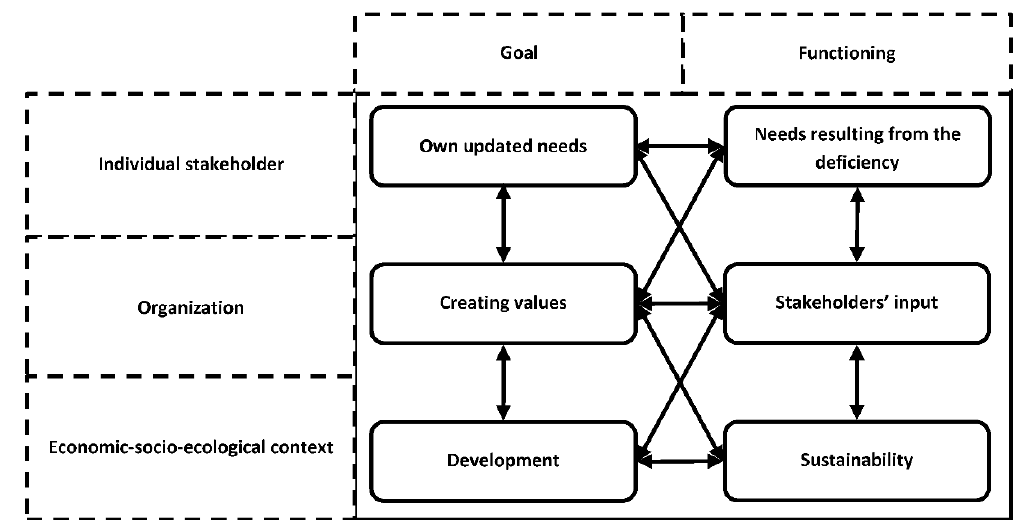
Figure 3. Sustainability enterprise design model. Source: Own study 2012, based on: A.M. Genaidya, R. Sequeira, T. Tolaymat, J. Kohlerc, S. Wallace, M. Rinder, Integrating science and business models of sustainability for